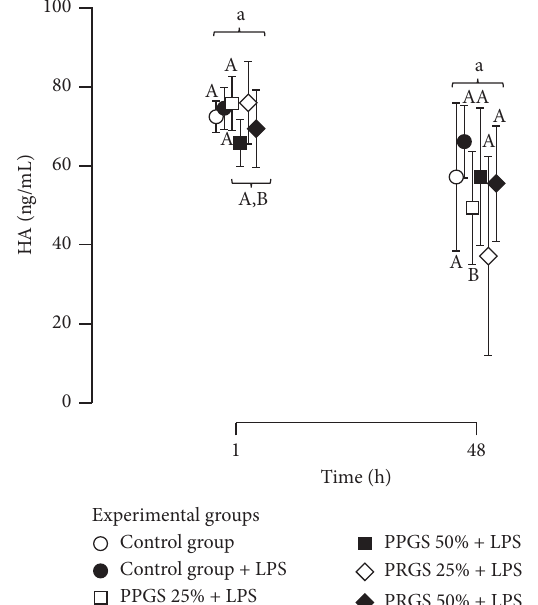
Figure 5: Mean ( ± SD) HA concentrations (ng/mL) in culture media from experimental groups at 1 and 48h. Different lower-case letters represent significant ( P < 0 . 01 ) differences between exper- imental groups at each independent time point. Different capital letters represent significant ( P < 0 . 01 ) differences for the same experimental group at different times. HA, hyaluronan; IL, in- terleukin; LPS, lipopolysaccharide; PLT, platelet; PDGF-BB, platelet-derived growth factor isoform BB; PPP/PPGS, platelet- poor plasma/platelet-poor gel supernatant; PRP/PRGS, platelet- rich plasma/platelet-rich gel supernatant; TGF- β 1 , transforming growth factor beta 1; WBC, white blood